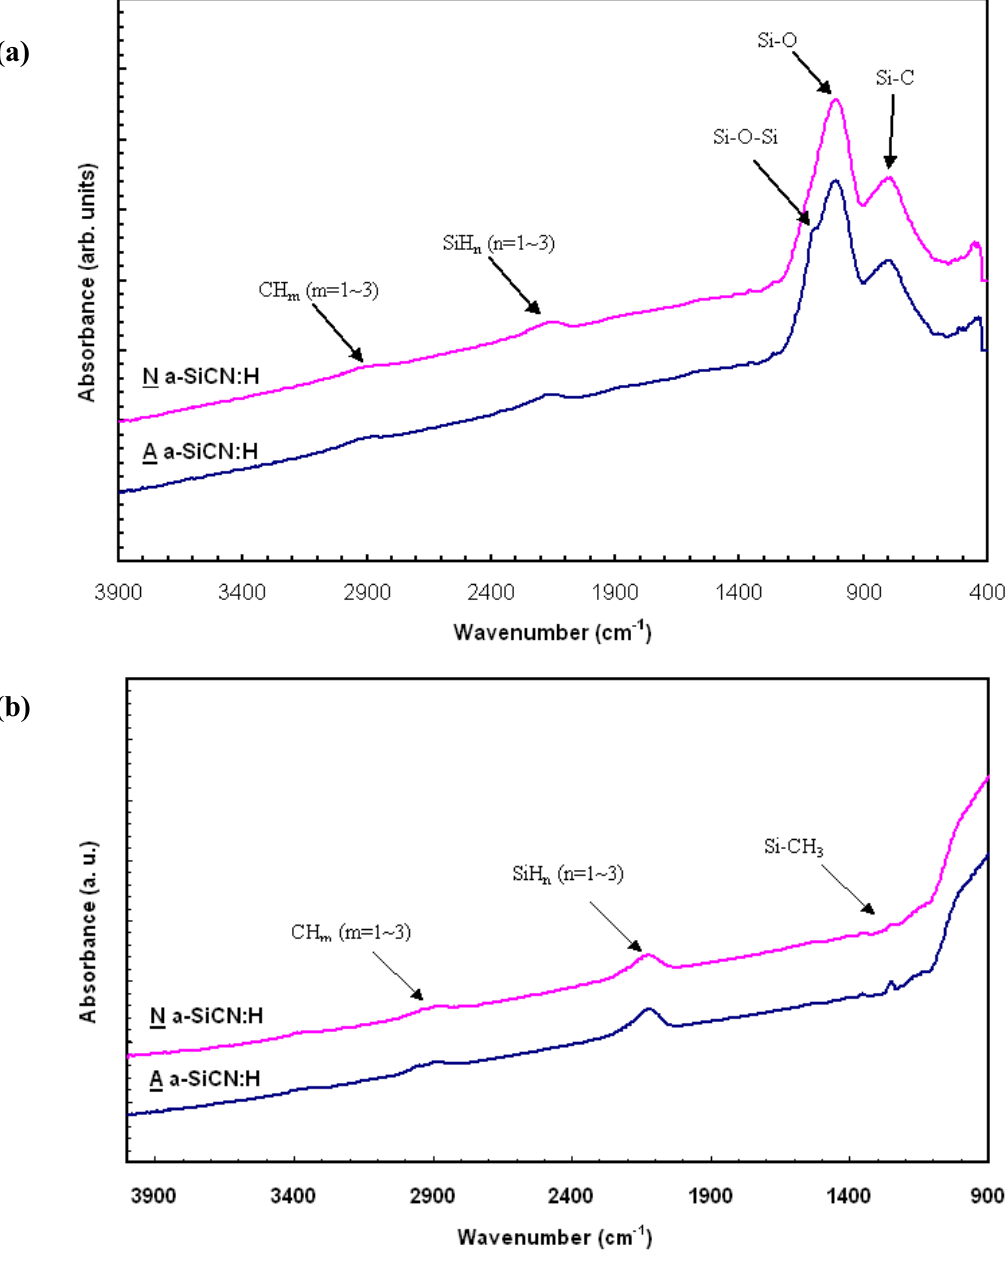
Figure 2. The FTIR spectra of α -SiCN:H film deposited by trimethylsilane (3MS) ( a ) and tetramethylsilane (4MS) ( b